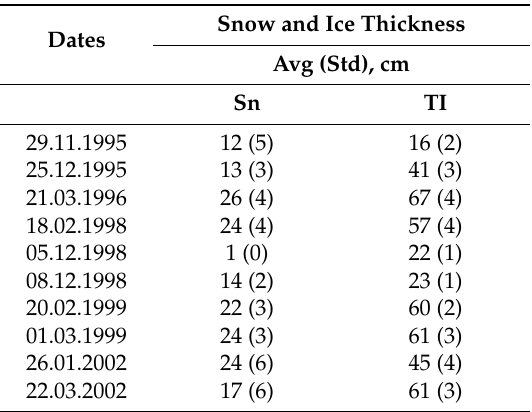
Table 2. The spatial average (Avg) and standard deviation (Std) of thickness of snow (Sn) and total ice (TI) over stations of cross ‐ section in early and mid ‐ winter in different years. Snow and Ice Thickness Avg (Std), cm Dates